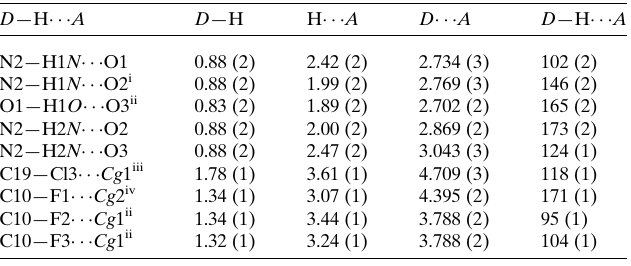
Table 1 Hydrogen-bond geometry (A˚ , (cid:4)